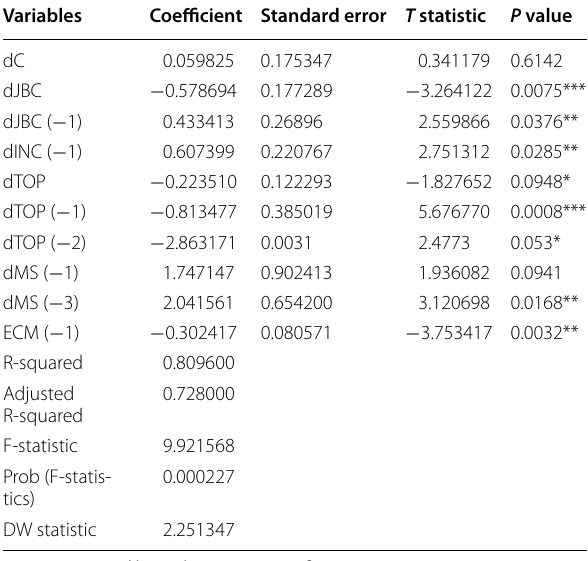
Source Computed by Authors using Microfit 5.1 *, **, and *** show 10, 5 and 1% levels of significance